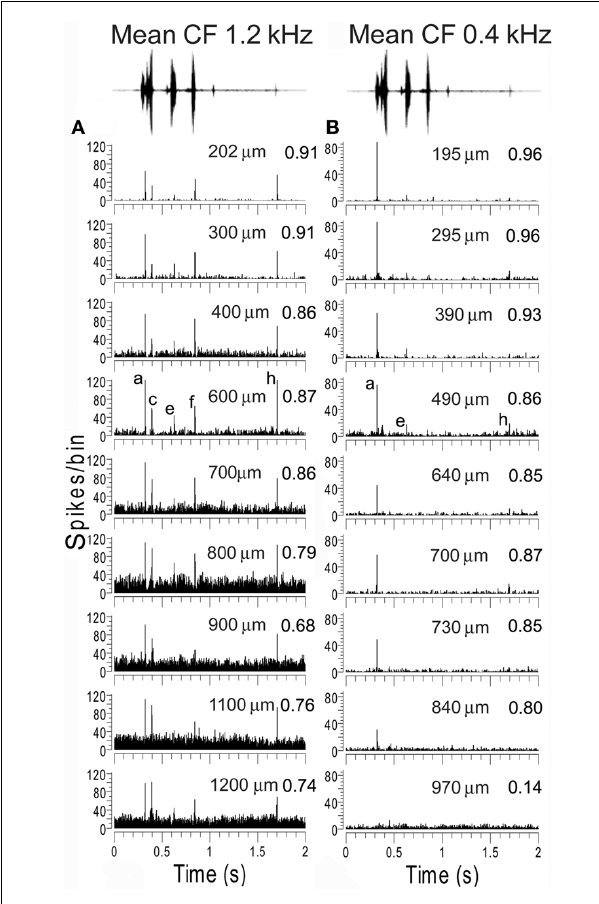
FIGURE 9 | Recordings from units at various depths from two experiments where an electrode was inserted into AI(LF) in tracks oriented orthogonally to the surface. The mean CF of units in each track is shown at the top as well as the waveform of the chutter. The elements responded to by each unit within one track are remarkably similar. The units in track (A) all respond to the same five elements although the response to element (e) is very small in a few of the deepest units. Their similarity is indicated by the value on the right hand side of each panel which shows the correlation between the PSTH and the mean PSTH for that track. The units in track (B) primarily give an onset response to element (a) although the response gets smaller with increasing depth until by the deepest unit there is no longer any significant response to this element. The upper units also show a response to element (e) and two of the units also give a small response to (h). Thus, although not identical the responses are similar as shown by the correlation values at the right of each panel.